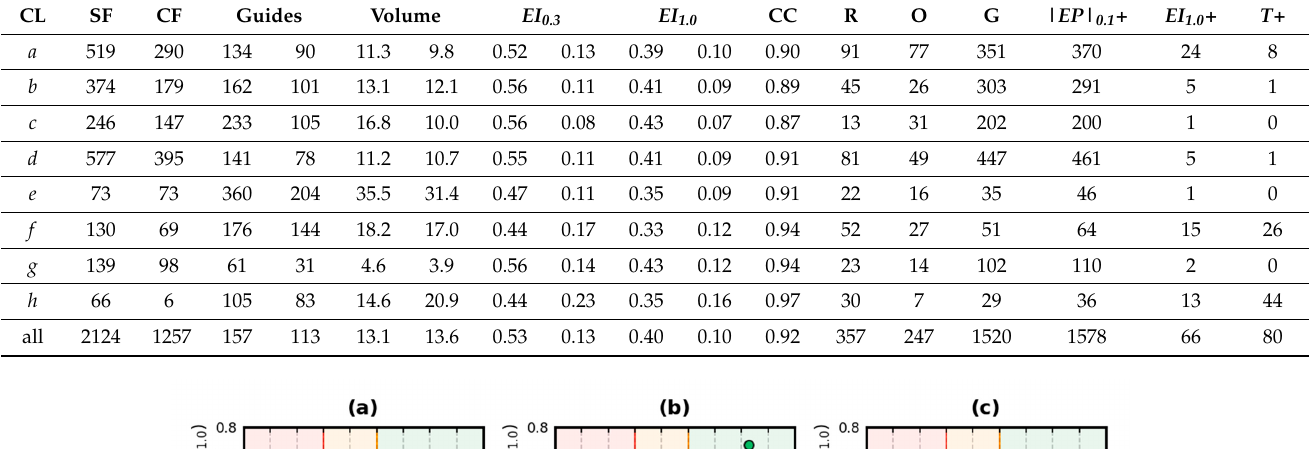
Table 6. Results of application of EP algorithm to SCOP 2.08 domain superfamily representatives using m = 0. Average number of guide effective atoms is for m = 0 equal to the average number of all residues in the domains. See description of Table 5 for more information how to interpret this table.